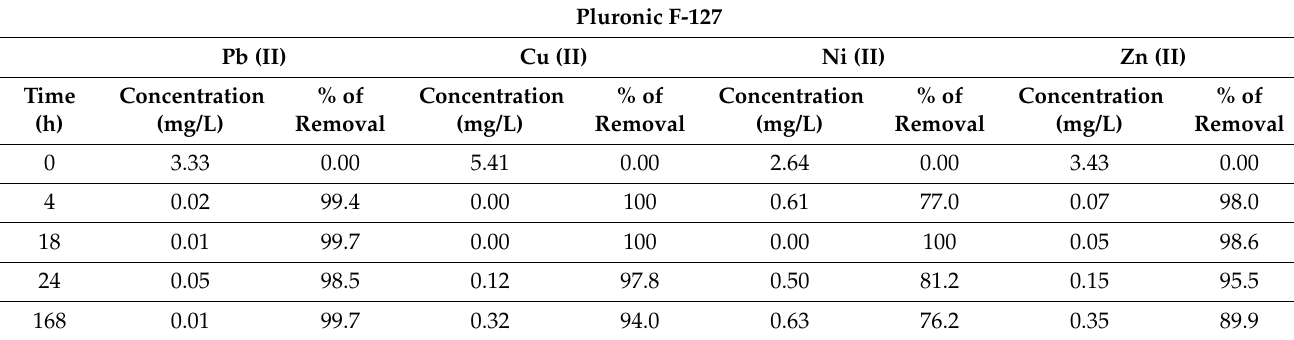
Table 4. Removal of Pb(II), Cu (II), Ni (II) and Zn (II) by a suspension of 0.01% ( w / w ) of MWCNTs in a solution of 0.03% ( w / w ) of Pluronic F-127.